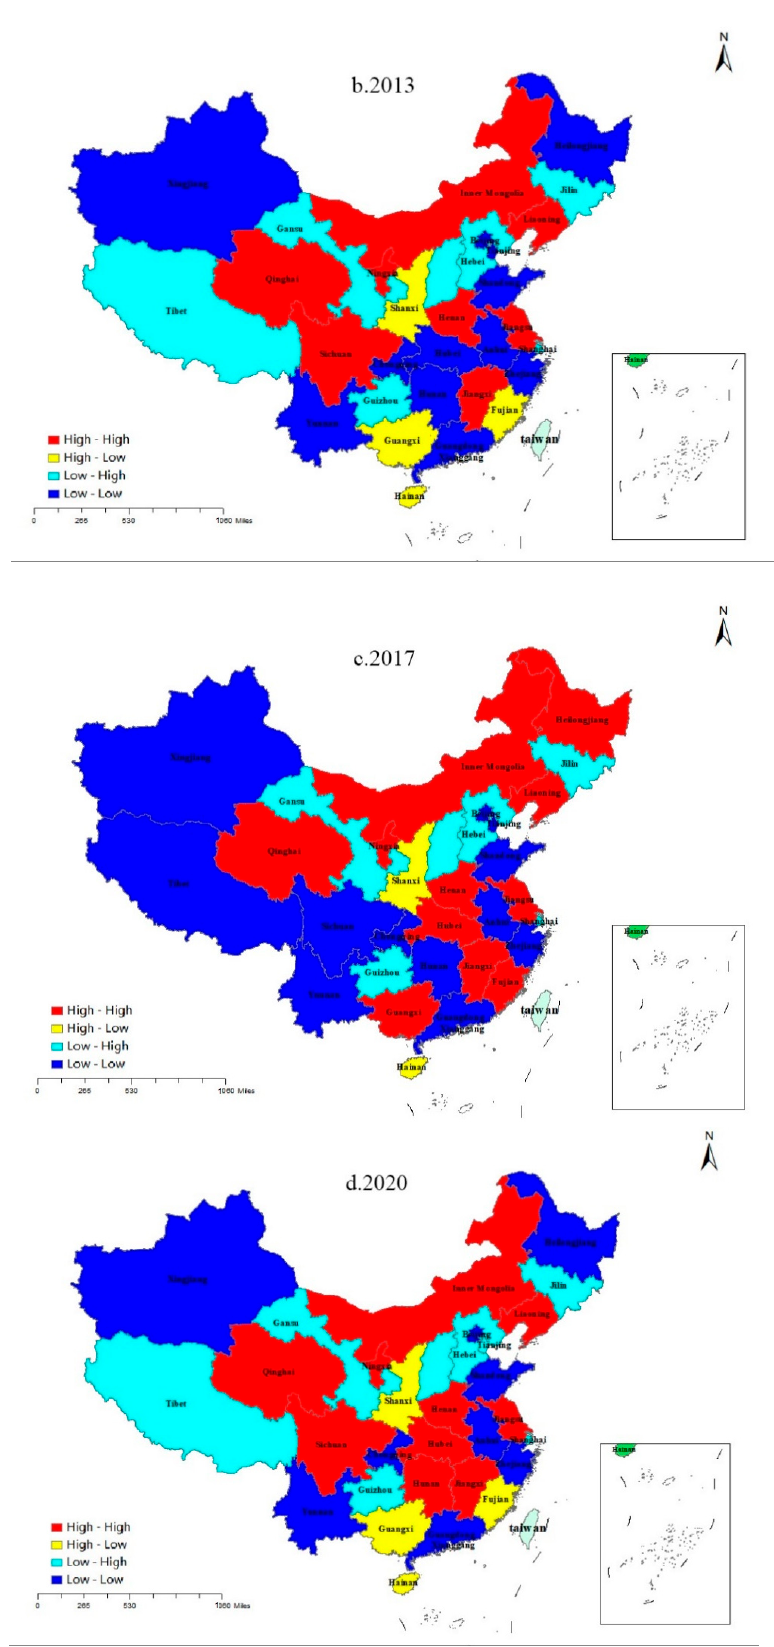
Figure 3. LISA cluster map of China’s agricultural economy in 2011, 2013, 2017, and 2020 . Overall, the high–high (H–H) agglomeration areas are mainly concentrated in the central region and are also involved in the eastern and western regions [22]. The specific provinces are Hubei, Hunan, Jiangxi, Jiangsu, Inner Mongolia, Qinghai, Sichuan, Liao- ning, Ningxia, and Henan. Low–low L–L agglomeration areas are mainly scattered in China’s border provinces, including Guangdong, Yunnan, Chongqing, Zhejiang, Anhui, Shandong, Beijing, Heilongjiang, and Xinjiang. From the perspective of changing trends, the H–H agglomeration of China’s agricultural economy is showing a trend of spreading from the central region to the surrounding areas. The L–L agglomeration in the central and western regions is gradually decreasing. Thus, under the new economic development pattern, the agricultural economy is developing rapidly, the overall agricultural economy in the central region is developing to a high level, and it is constantly driving the devel- opment of the surrounding areas [23]. 5.2. Theoretical Framework Analysis of Influencing Factors At present, research on agricultural economics has mainly focused on the construc- tion of relevant index systems, comprehensive evaluation, and exploration of influencing factors [24]. In the process of promoting the development of the agricultural economy and improving its development level in an all-around way, the status of the agricultural eco- logical environment should be given attention. A good agricultural ecological environ- ment can create favorable conditions for the normal growth of crops, provide more sup- port for the development of the agricultural economy, and meet the needs for increased benefits and scientific development [25]. Spatial Geographical Factors. Through the theoretical analysis of spatial economet- rics, a certain attribute or phenomenon of an area and the attribute value of its adjacent area are related to the previous phenomenon. Therefore, when making suggestions, the influence of spatial correlation should be included, such that the proposed recommenda- tions are more scientific and reliable. This study expects that the spatial and geographic factors positively affect China’s agricultural economy. Production Scale Factor. From a traditional point of view, the production scale of a region is directly related to the agricultural economic output value. When the production scale of a region is larger, the corresponding crop yield will increase, and its production scale is mainly reflected in the sown area, fixed asset investment, and crop yield. In addi- tion, the increase in the production scale of the region may be due to a large amount of